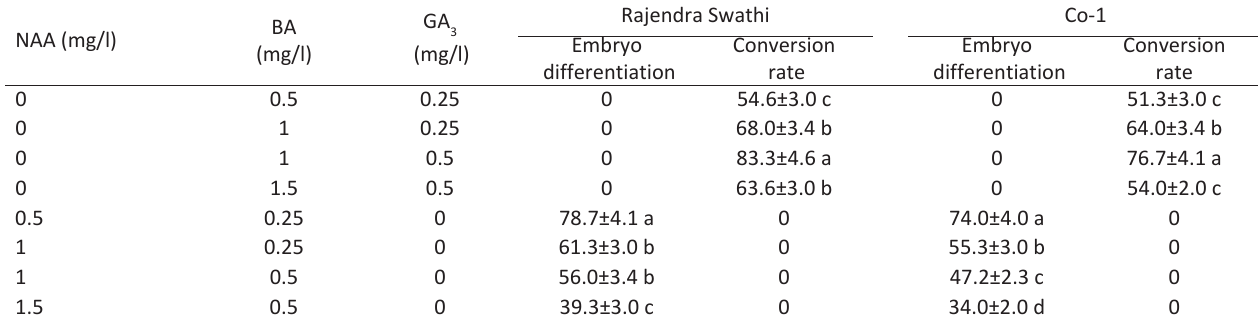
Table 2 - Somatic embryo differentiation and germination frequency in ‘RS’ and ‘Co-1’ on different concentrations of NAA, BA and GA 3 supplemented MS